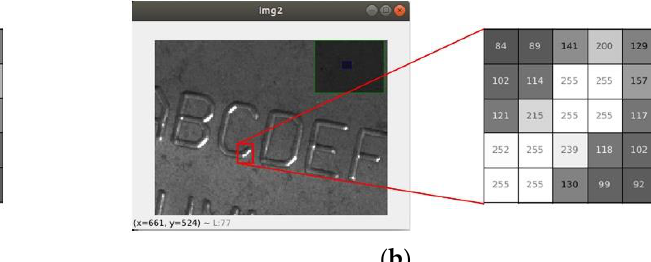
Figure 7. Pixel noise in the images captured by using the CMOS camera; images were captured at intervals of 1 s, under the same aperture, exposure, and lighting conditions. ( a ) Pixel values of the image taken first ( b ) Pixel values of the images taken after one second.